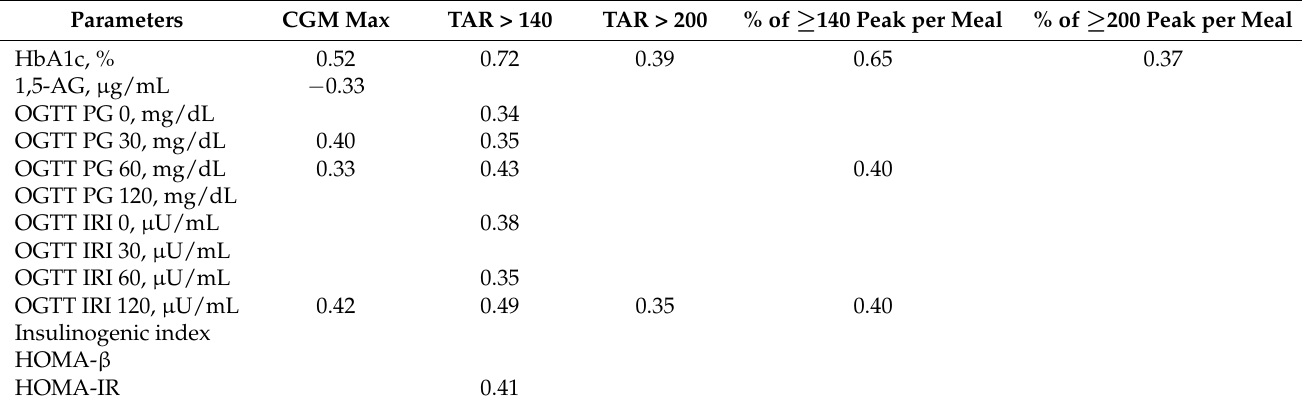
Table 1. Spearman’s rank-order correlation coefficients ( ρ ) of significant associations between biochemical indices and CGM